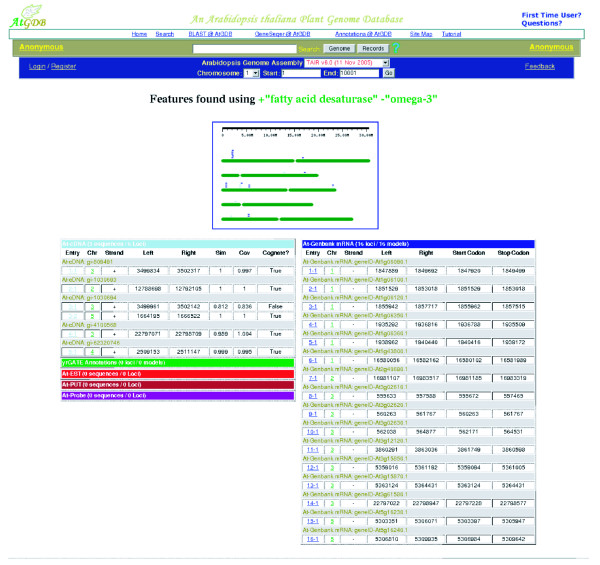
Search results at AtGDB using the query +"fatty acid desaturase" -"omega-3". The '+' and '-' operators represent inclusion and exclusion, respectively, following the convention of MySQL boolean text searches [39].